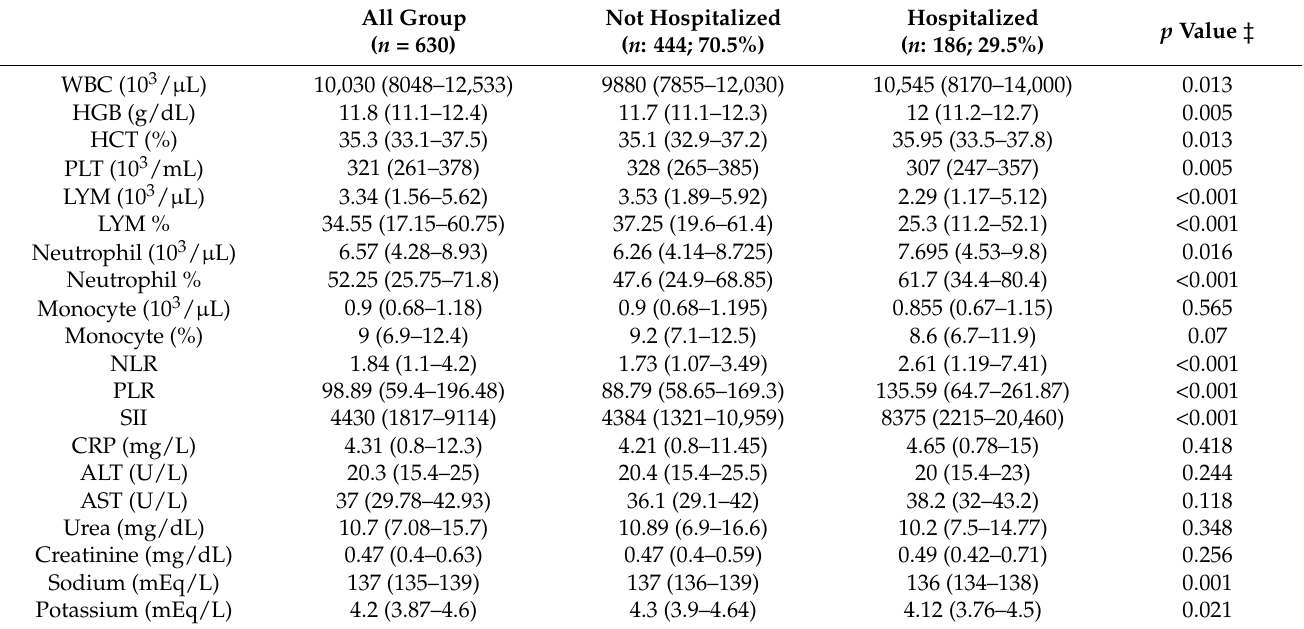
Figure 4. Box-plot graph by hospitalization groups, ( a ): NLR; ( b ): PLR; ( c ): SII. Points ( • ) are represents the outliers. Table 5. Laboratory findings of hospitalized and not hospitalized children with rotavirus infection.